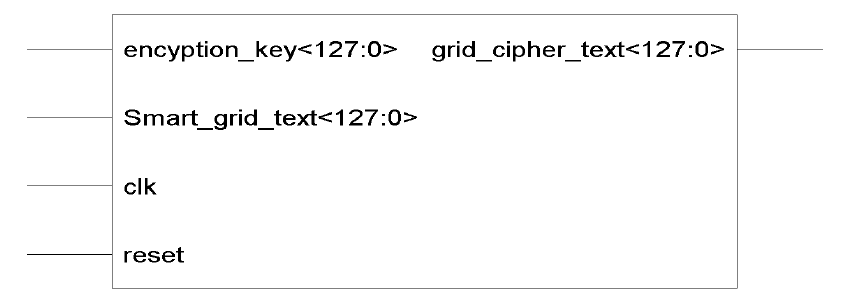
Figure 1 RTL view of grid encryption